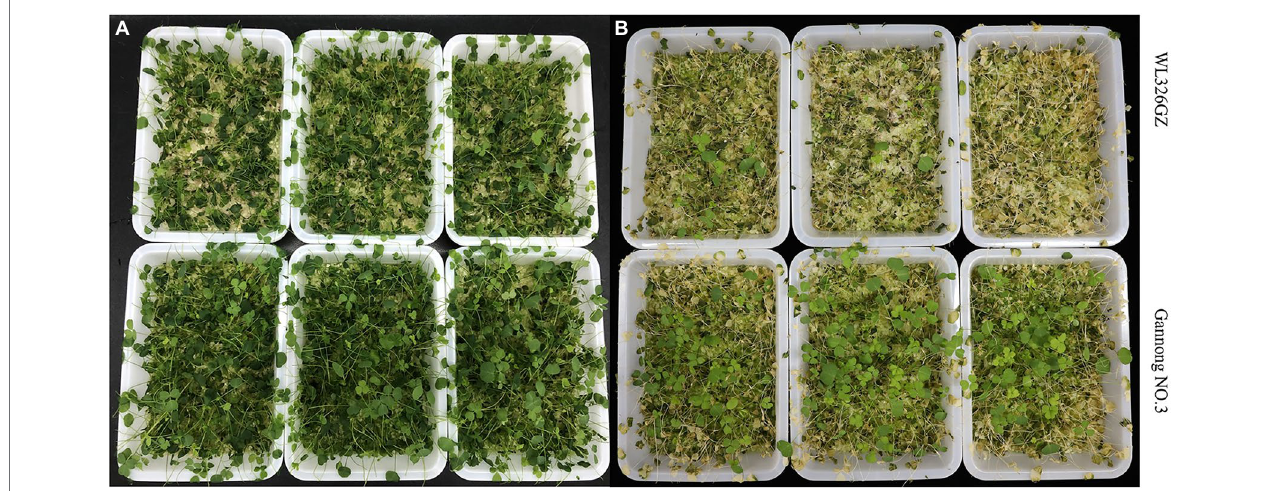
FIGURE 1 | Phenotypes of two alfalfa cultivars after exposure to − 10 ° C. (A) The phenotype of “WL326GZ” and “Gannong NO.3” exposure to − 10 ° C for 2 h. (B) The phenotype of the (A) growth in the normal temperature for 2